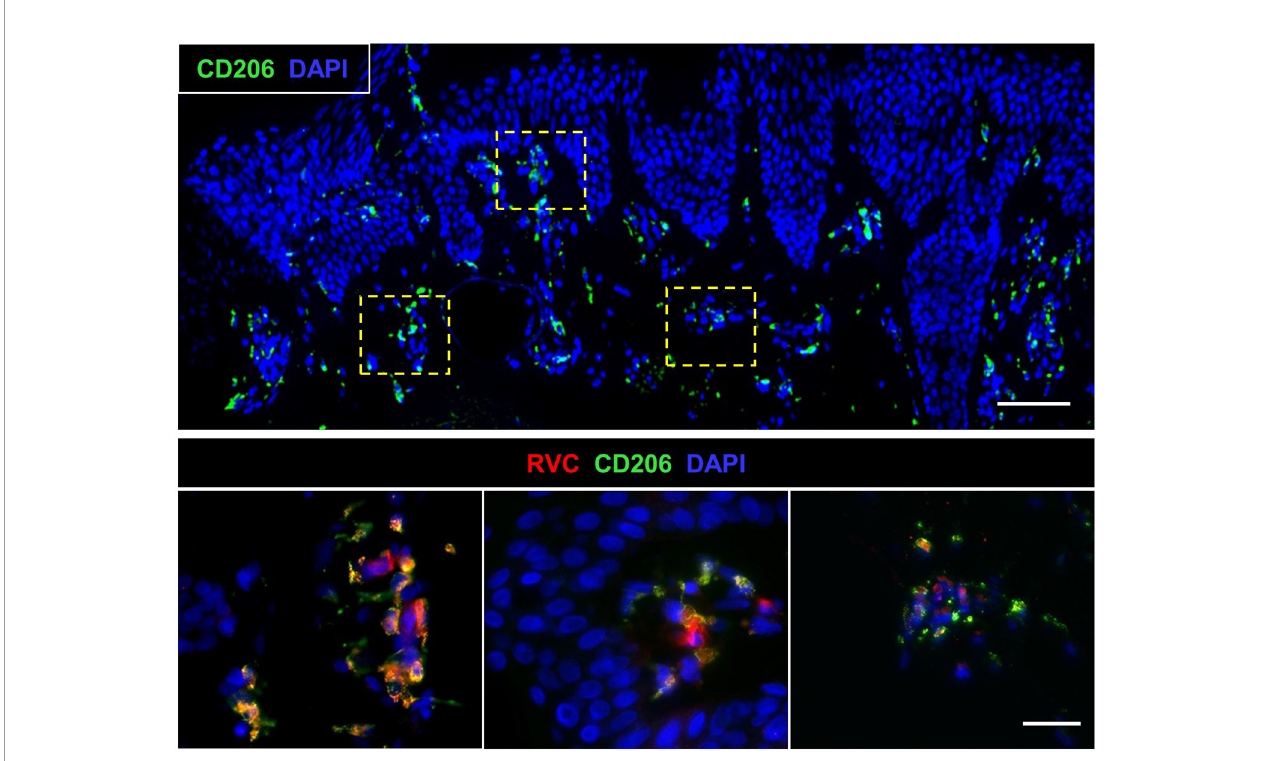
FIGURE 5 | Biopsy of a newly developed cutaneous lesion (P1). Double histological immuno fl uorescent staining shows small clusters of RVC + CD206 + M2 macrophages under the epidermis. Scale bars: 100 µm (top panel) and 20 µm (bottom